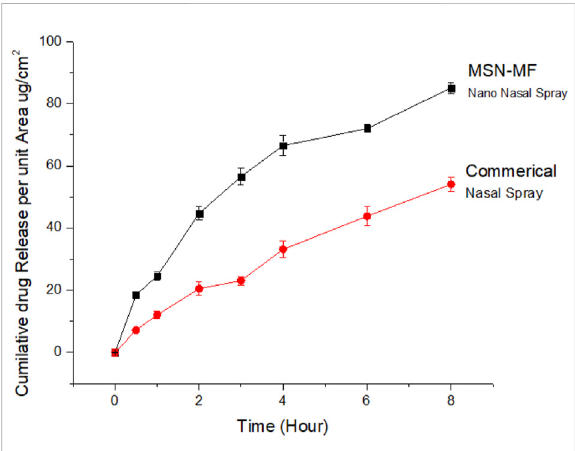
FIGURE 7 MF release from MSN-MF nano-nasal spray through the silicon membrane compared with the commercial nasal spray.